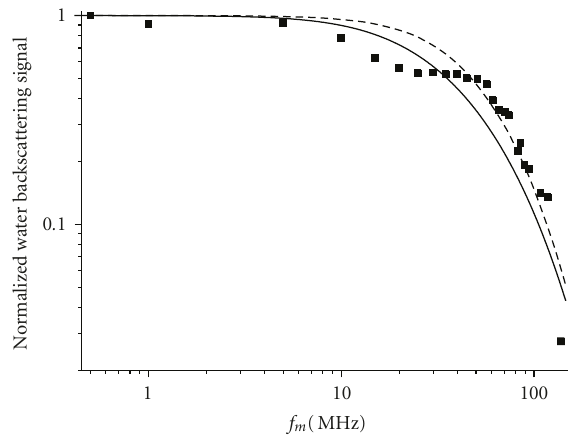
Figure 3: Normalized optical noise versus f m for k = 0 . 66m − 1 . Filled squares represent the experimental measures. The other curves were obtained by means of the theoretical model with r rec = 0 . 2m, θ FOV = 0 . 117rad, r 0 = 0 . 025m and the following values for the other parameters: (1) k (cid:6) = k = k d (dashed line); (2) k (cid:6) = 0 . 201m − 1 , k f s = 0 . 459m − 1 , (cid:13) θ 2 (cid:14) = 0 . 036 (solid